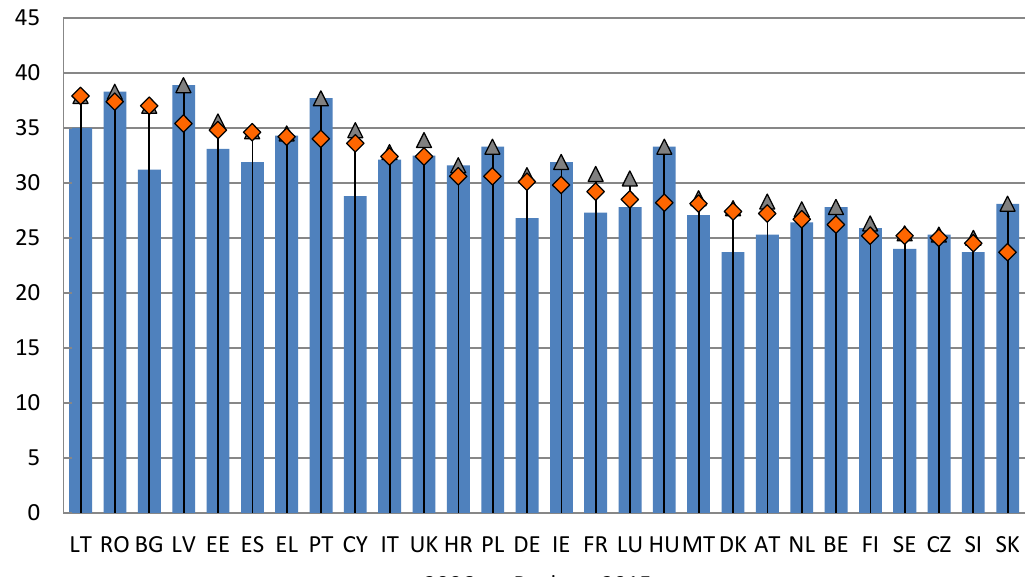
Figure 7 . Gini coefficient of equivalized disposable income in the EU-28 countries (2006, 2015, and period peak). Source: Own elaboration based on statistics from Eurostat. Notes: (i) Countries appear ranked according to the highest Gini coefficient in 2015. (ii) Croatia's data correspond to 2010 instead of 2006; Romania's data correspond to 2007 instead of